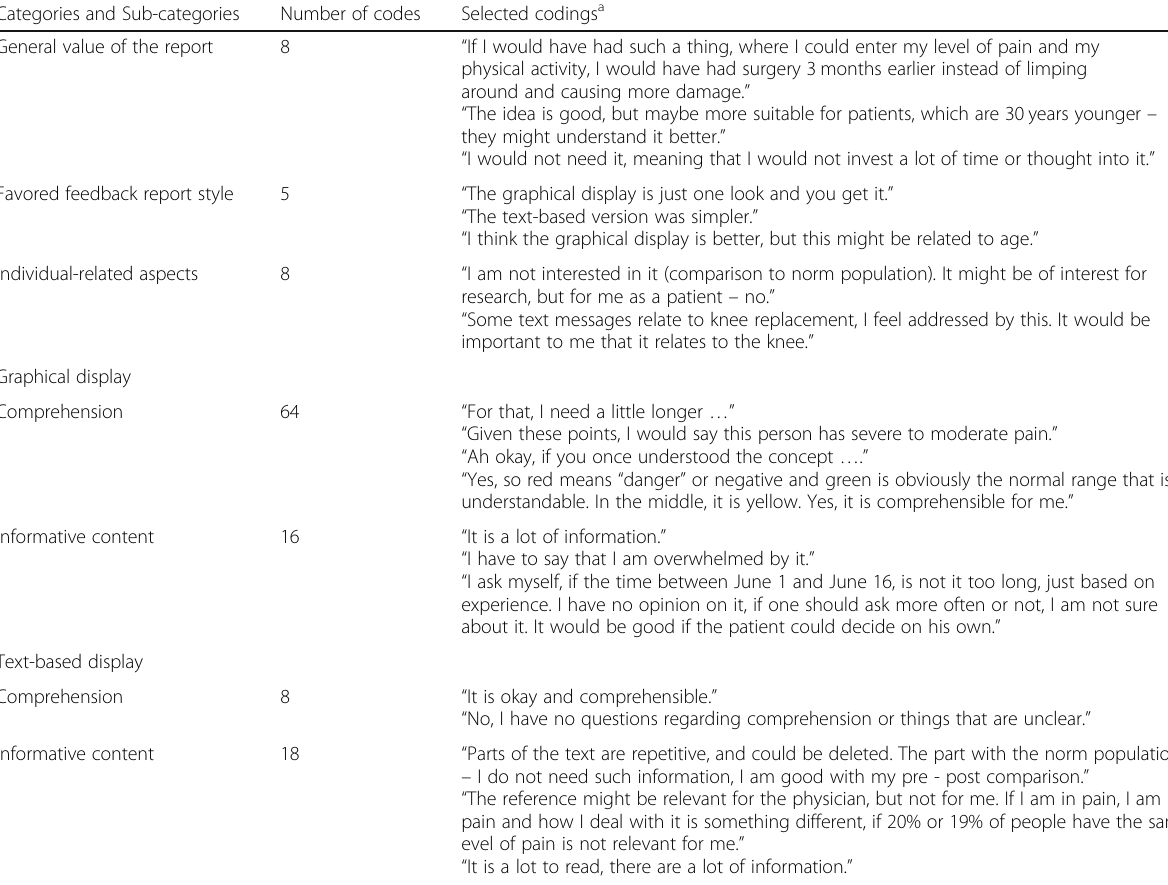
Table 4 Coding structure of the interviews, number of codes and coding